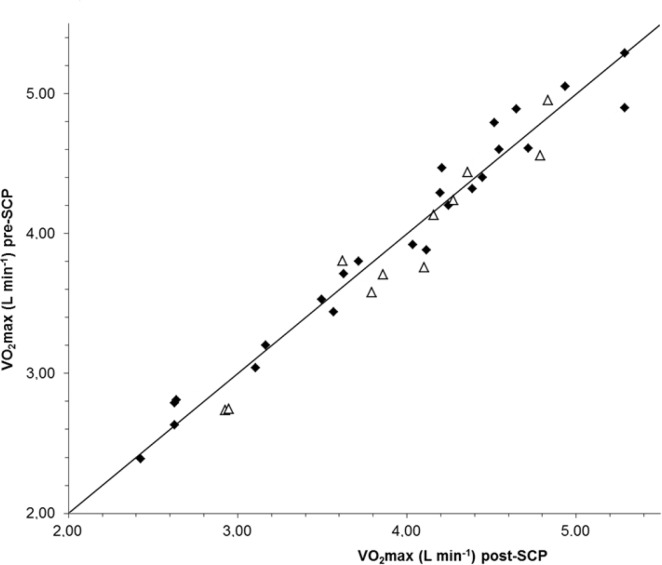
Individual VO2max pre- and post the snuff cessation (SC) or for the control situation. Solid symbols represent snuff cessation group and open triangles are the control group.